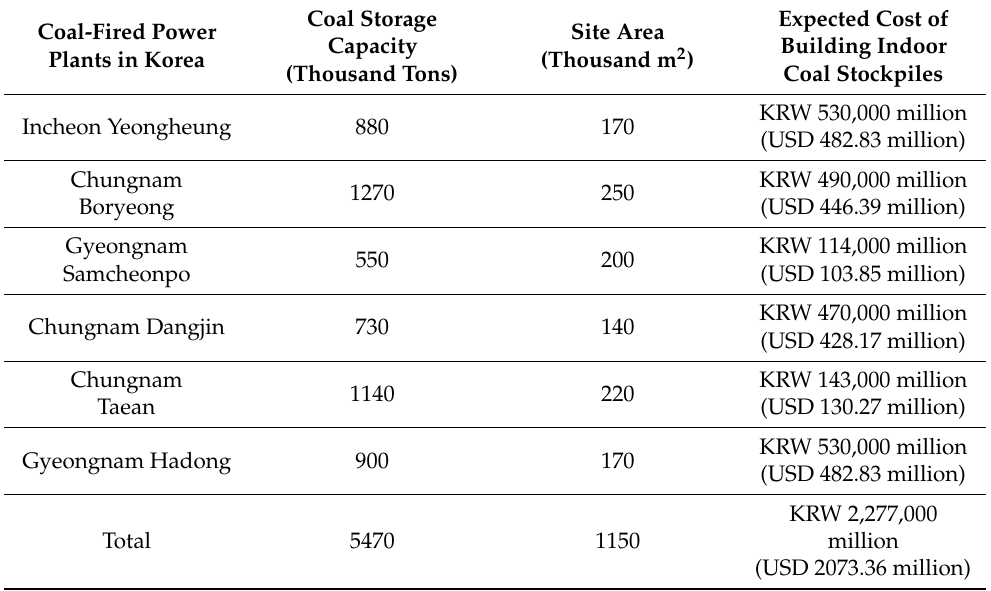
Table 6. Status of outdoor open coal stockpiles of Korea’s six major coal-fired power plants and expected cost of building indoor coal